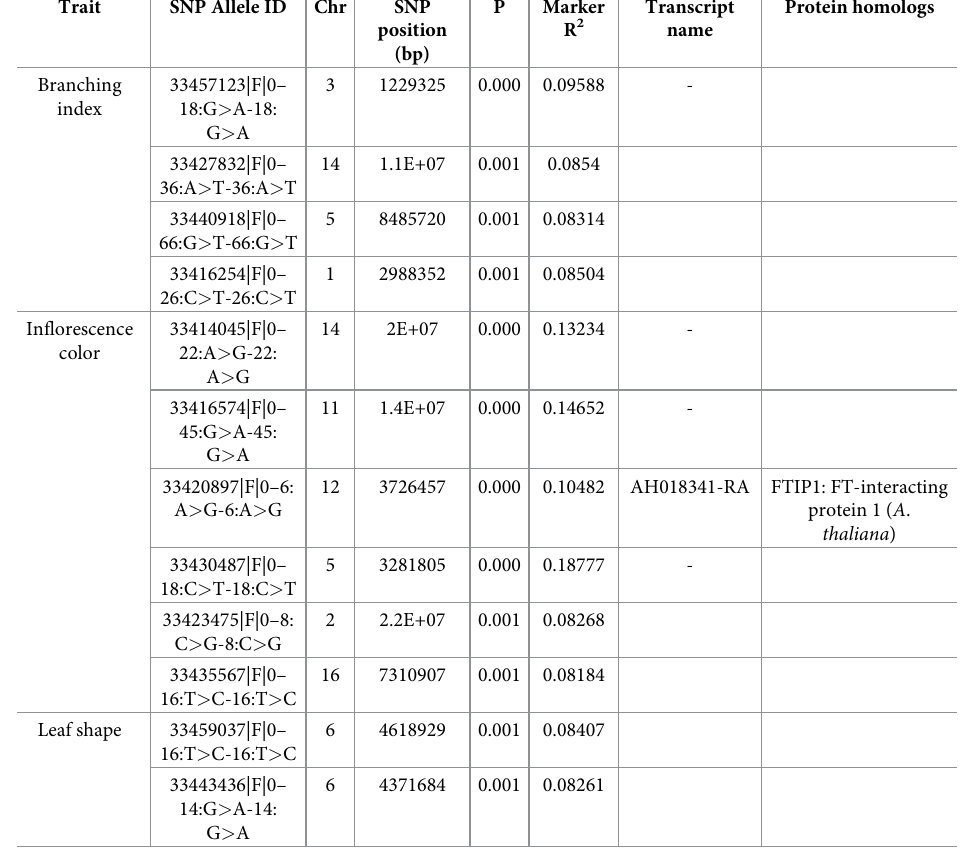
Table 2. 12 MTAs (P � 0.001) of three morphological traits; branching index, inflorescence color and leaf shape in 16 amaranth